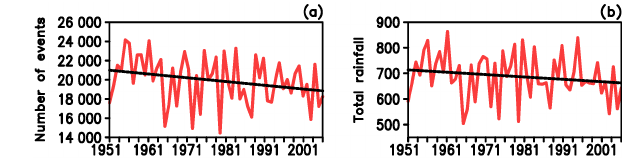
Figure 2. Time series of number of observed moderate rainfall events over CI and total rainfall in JJAS (in mm; 1951–2007) from APHRODITE rainfall data. (a) Moderate rainfall events and (b) to- tal amount of rainfall in moderate category. Black dotted line repre- sents the linear